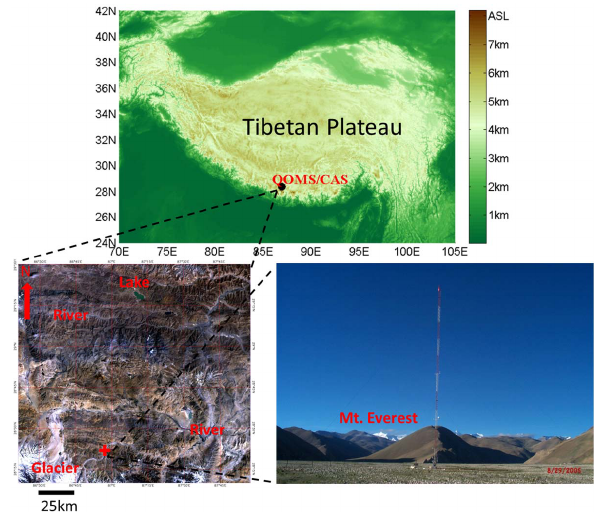
Figure 1. The landscape of the Tibetan Plateau (top), study area (bottom-left picture, composites of TM band 2, 3, 4) and environment around the QOMS/CAS station (bottom-right).